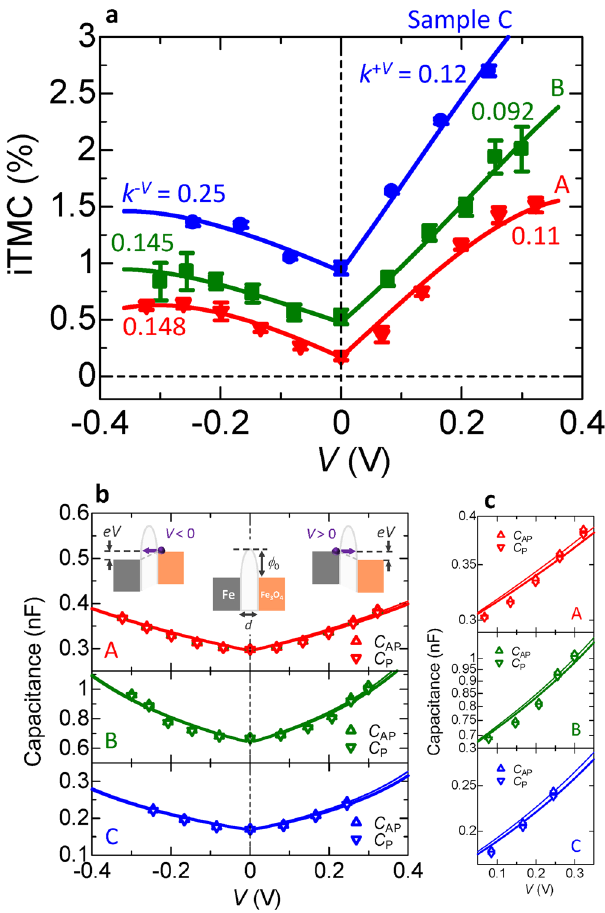
Figure 4. Bias dependence of the inverse TMC. Positive and negative bias dependence of ( a ) the iTMC ratio, ( b ) the capacitance C P(AP) of the P(AP) configuration and ( c ) the log-scaled C P(AP) in the positive bias region for samples A, B and C, respectively. k μ is the ratio µ µ K K / , where μ denotes the positive or negative bias ( + V or P AP − V ). The insets of the panel b represent the potential barriers in the absence or presence of the bias voltage V